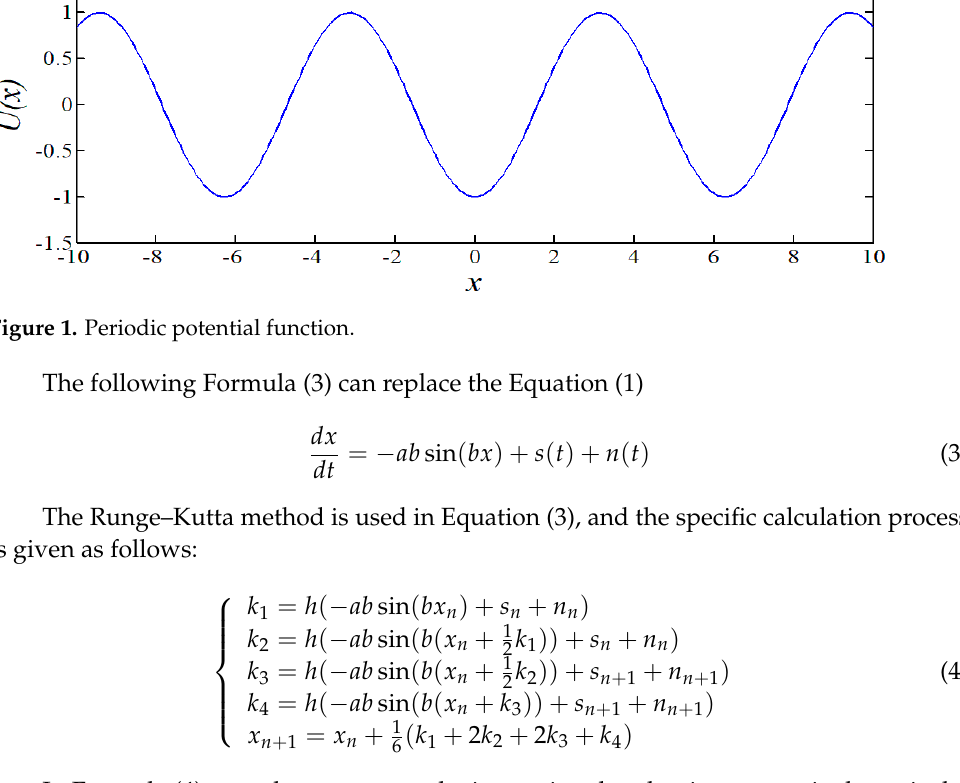
s and n represent the input signal and noise, respectively. In Formula (4) n n is the output signal and h is the iterative step of the numerical calculation.